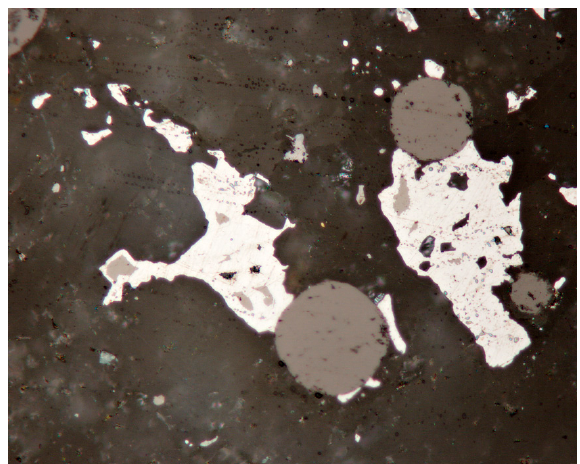
Figure 20. Brownish grey inclusions of cadmoselite in white clausthalite aggregates in association with grey spherical uraninite aggregates in calcite gangue. Reflected light, one polarizer. FOV 210 μ m. P ř íbram, a dump of shaft 16. Photo by P. Škácha.